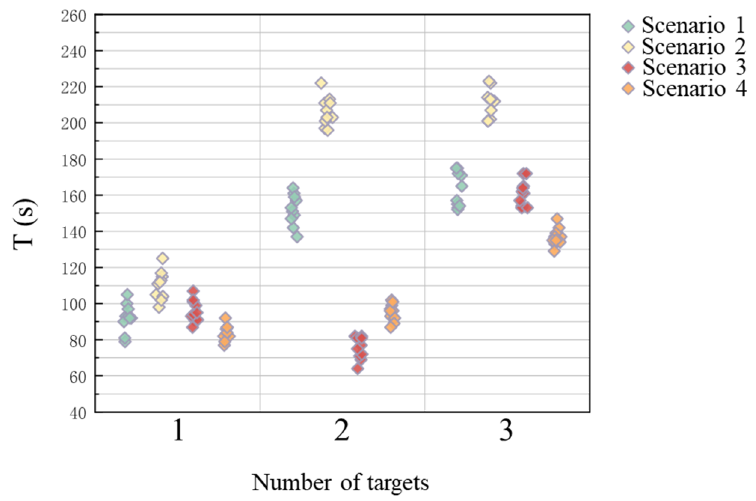
Figure 5. Efficiency comparison of the swarm game. This figure displays the time from the beginning to the completion of each experiment in seconds. Scenarios 1 to 4 correspond to the reduction of the number of altruistic robot individuals from three to zero, respectively. The efficiency of task completion is not simple, nor does it mean that more altruistic individuals are better.